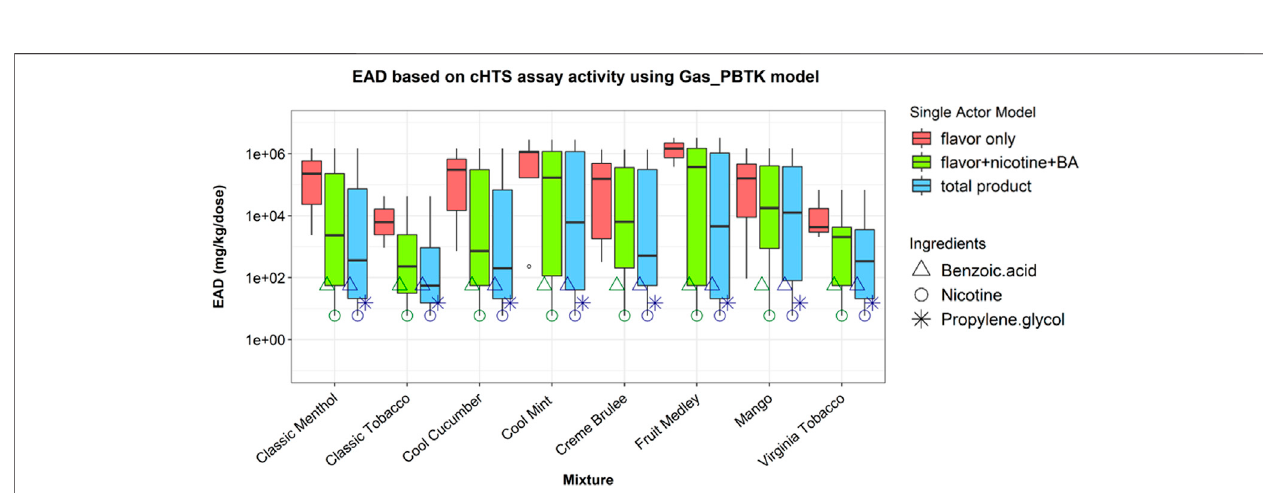
FIGURE 2 | EAD estimated using the HTS data for individual ingredients in the single actor approach. EAD estimates were generated based on each ingredient ’ s most sensitive bioactivity from the HTS assay and adjusted for the ingredient ’ s concentration in the e-liquid fl avor. The data were plotted based on each of three combinations: fl avor, fl avor + nicotine + BA, and total product. Boxplots show the distribution of EAD calculations for all considered ingredients using the single actor approach. Triangle, circle, and asterisk points indicate the EADs predicted when BA, nicotine, and PG were used as active ingredients, respectively.